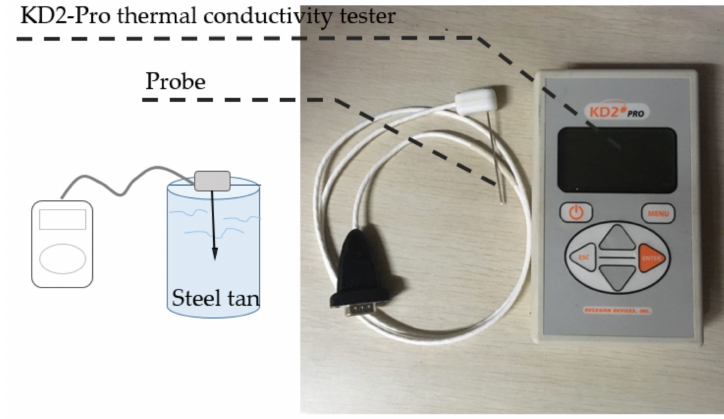
Figure 5. KD2 Pro thermal conductivity